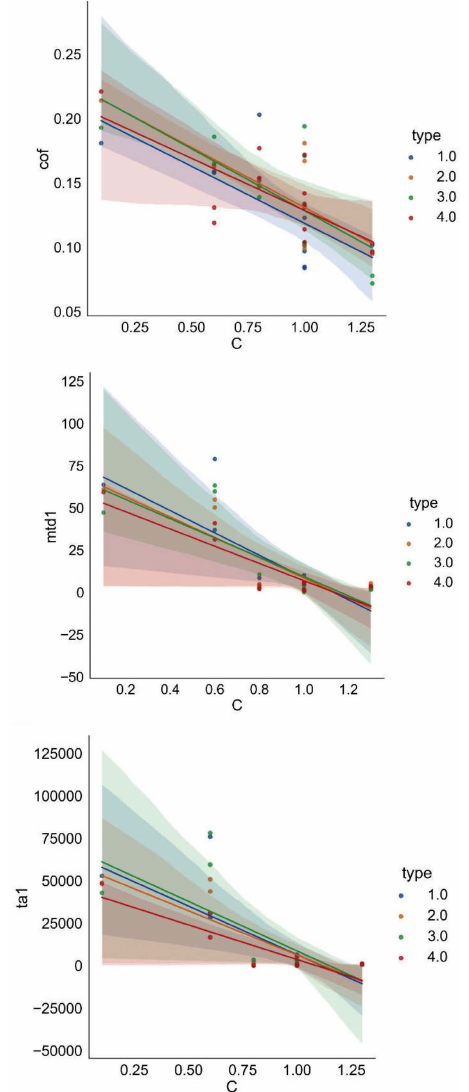
Figure 8. Relationships between the indices and carbon